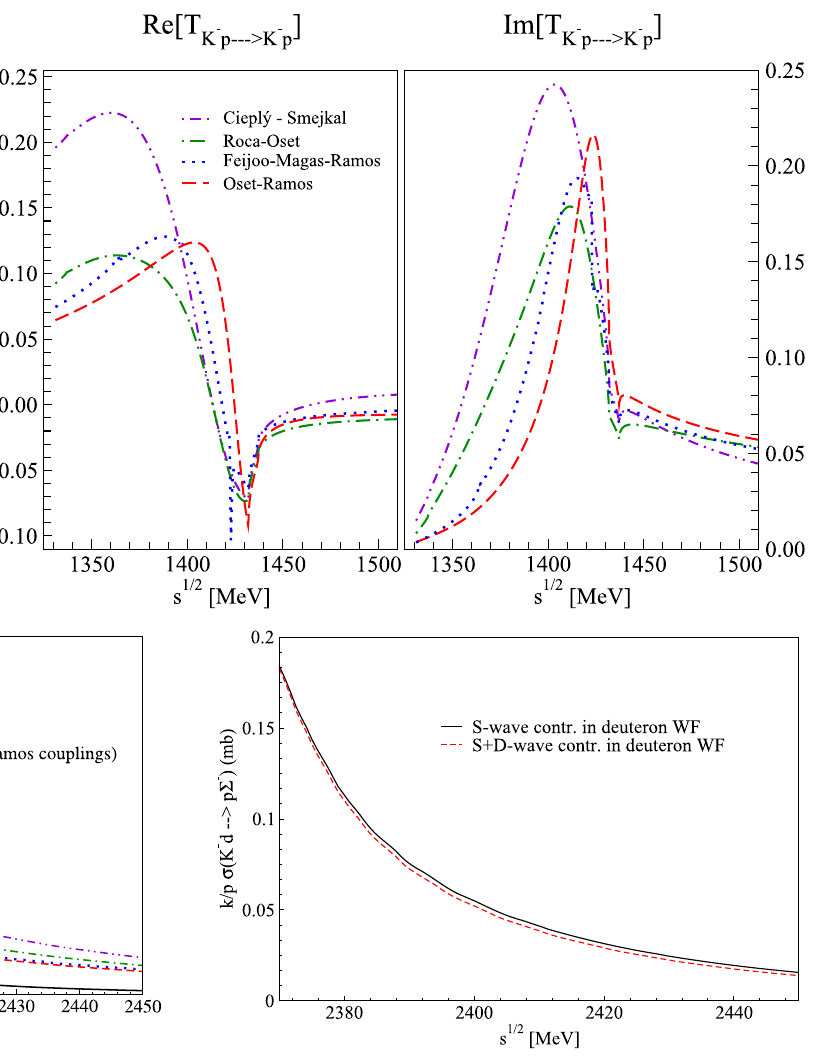
σ ) for the considered models. Fig. 11 K − d → p Σ − cross sections ( k Fig. 12 Effects of the S- and D-wave contributions of the deuteron p More details in the text wave function (WF) on the K − d → p Σ − cross section, for the domi- nant spin transition ( ↑↑→↑↑ ) and taking into account the Oset-Ramos Model for the S = − 1 meson-baryon